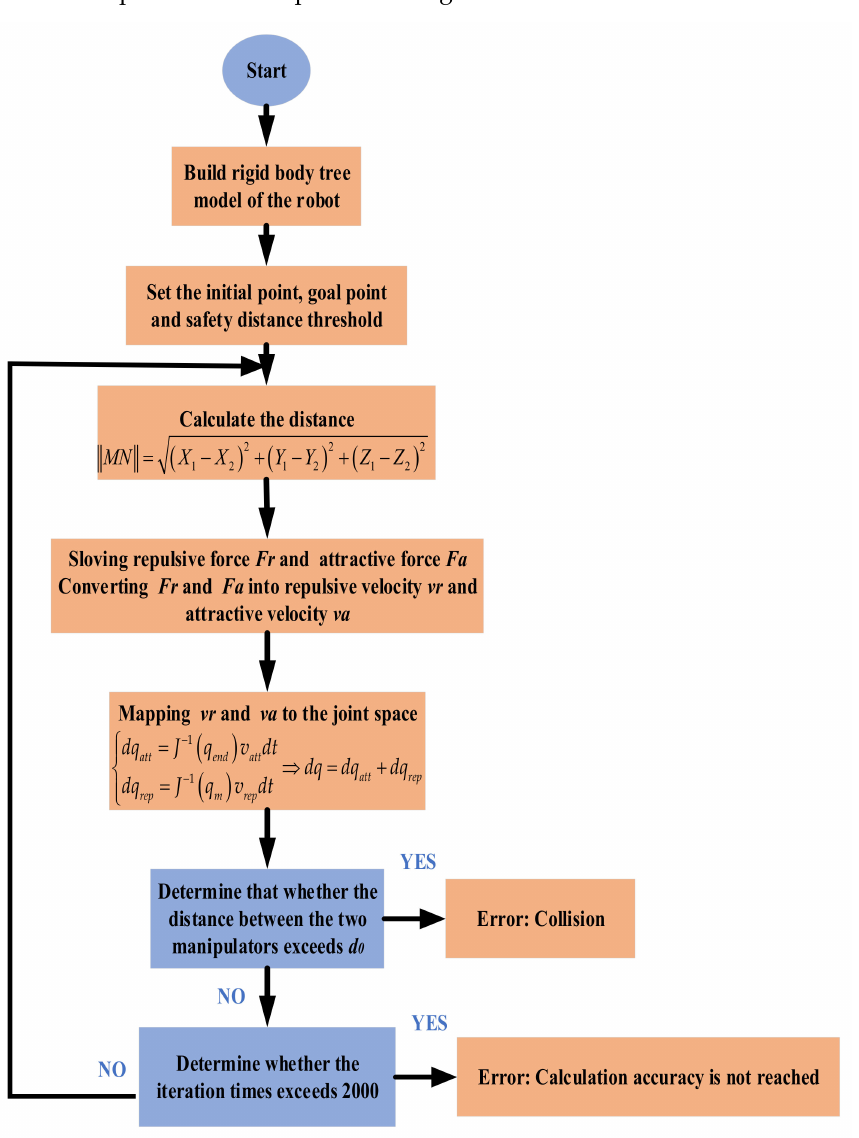
Figure 5. Flowchart of speed field with improved artificial potential field